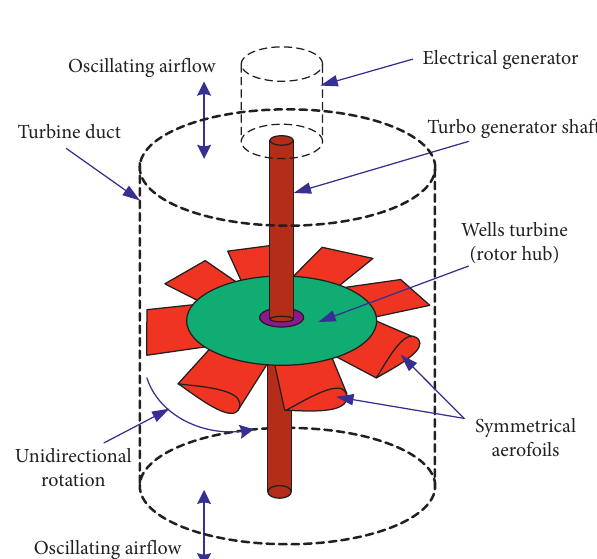
Figure 3: Wells turbine schematic diagram.